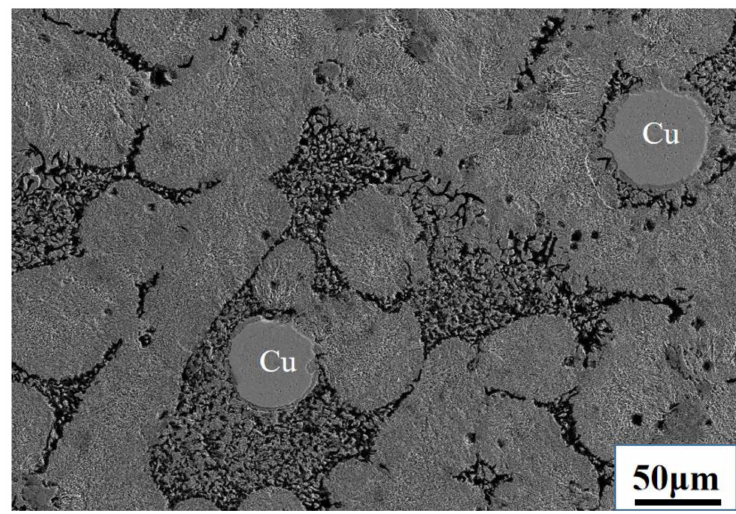
Figure 7. Electron microscope of Cu–Fe alloy after desulfurization by CaC 2.